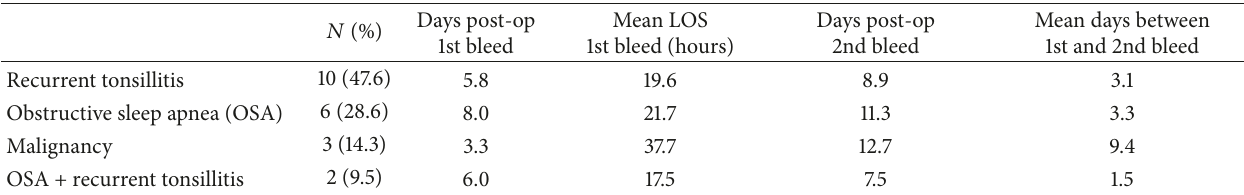
Table 2: Timeframe data for Group B (multiple PTH) patients, based on indication for tonsillectomy. 𝑁 (%) Days post-op